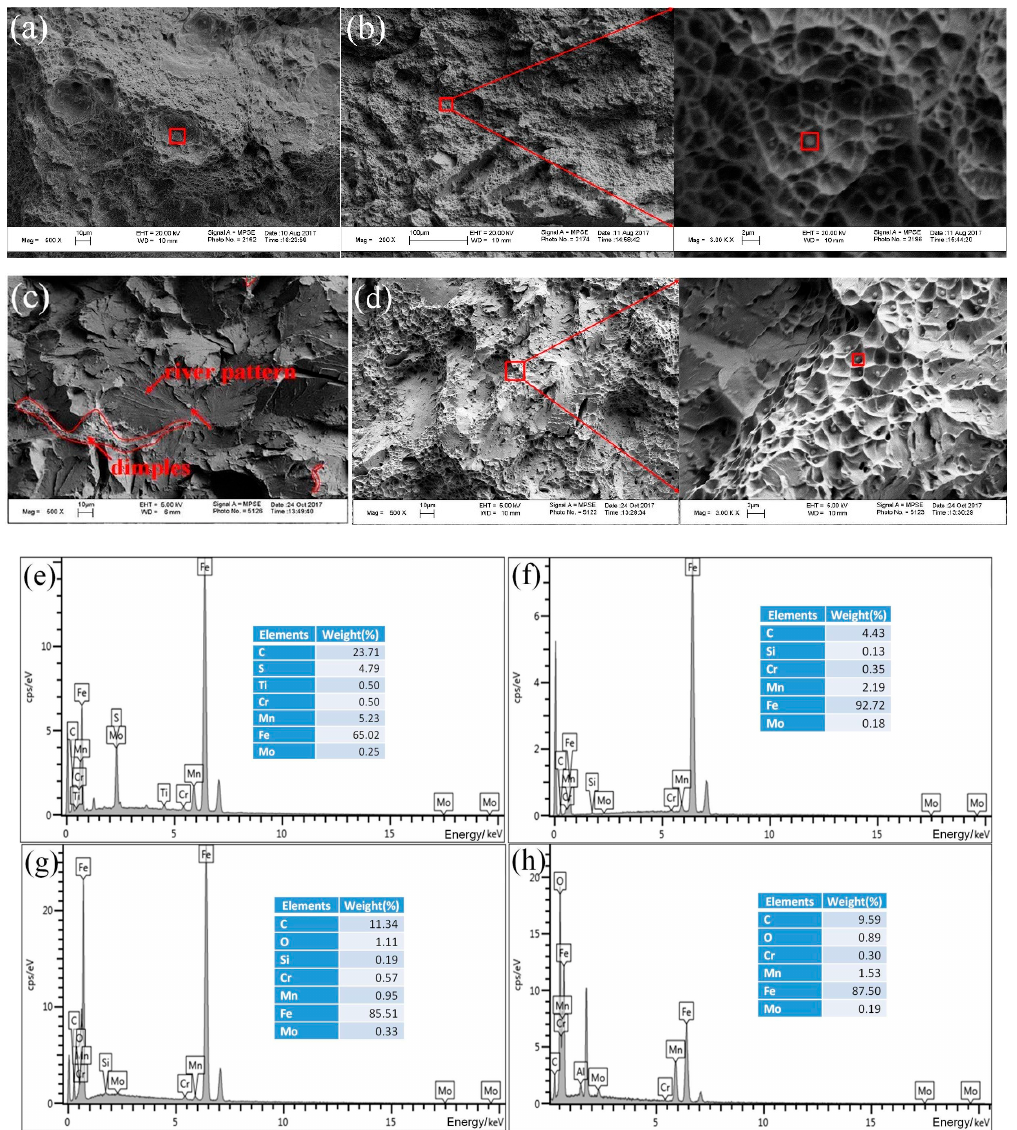
Figure 15. Fractured surfaces for the specimens after Charpy impact testing at − 40 °C and the results of EDS analysis: ( a ) UDW specimen with notch at the HAZ; ( b ) UDW specimen with notch at the FZ; ( c ) ULCW specimen with notch at the HAZ; ( d ) ULCW specimen with notch at the FZ; ( e ) EDS spectrum for an inclusion particle in ( a ); ( f ) EDS spectrum for an inclusion particle in ( b ); ( g ) EDS spectrum for an inclusion particle in ( c ); ( h ) EDS spectrum for an inclusion particle in ( d ).